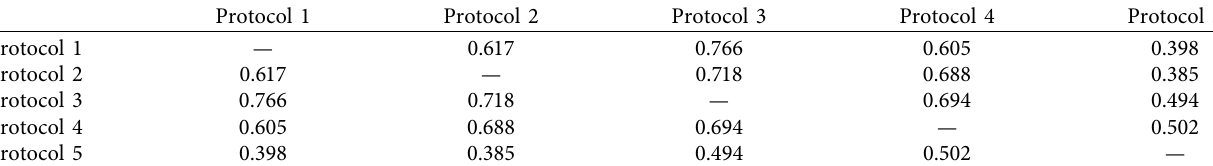
Table 4: Comparison of nodule detection rates between pairs of protocols (kappa